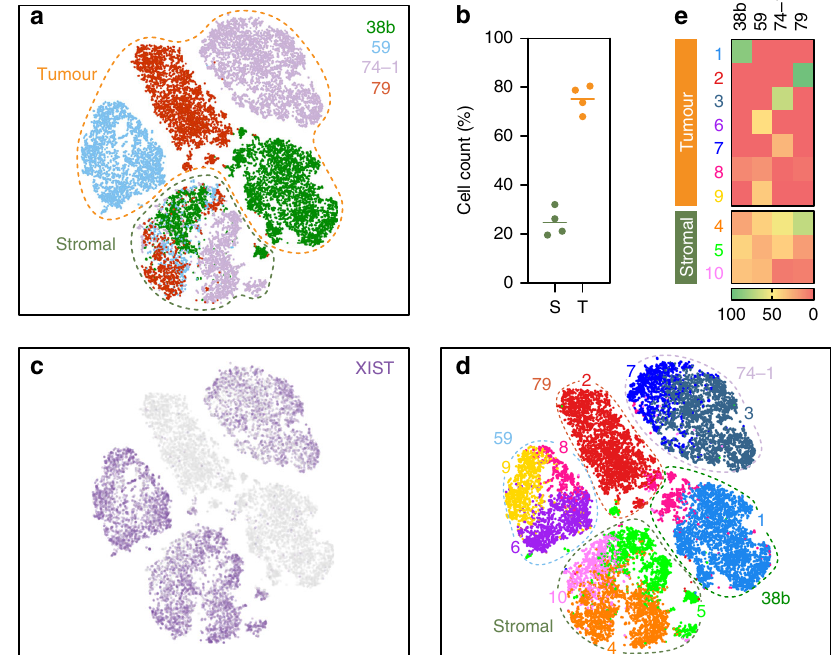
Fig. 5 10x Genomics single-cell transcriptomics. a t-Stochastic neighbour embedding (t-SNE) plot showing clustering of single cells from four OCM pairs, with tumour and stromal cells mixed 3:1. b Dot plots quantitating the percentage of cells in the stromal and tumour clusters. Line represents the mean ( N = 4 biological independent samples i.e. n = 1 for each of the four OCMs). c , d t-SNE plot from a overlaid with XIST expression ( c ) and 10 sub-populations identi fi ed by hierarchical clustering ( d ). e Heat maps quantitating the percentage of cells from each patient sample in the 10 sub-populations. Source data for panels b and e are provided as a Source Data fi